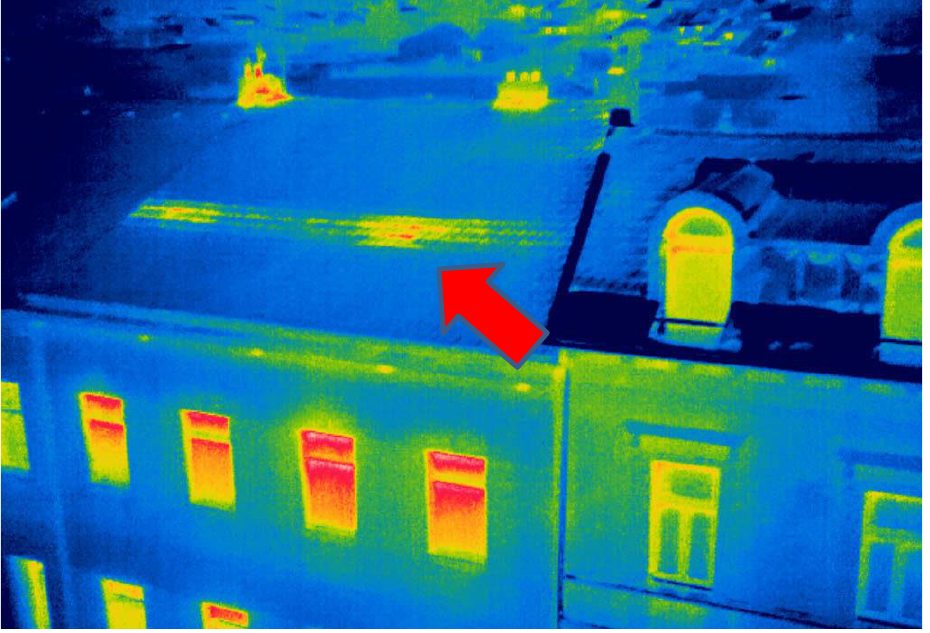
Figure 2: UAVs roof damage measurement caused by thermal bridges